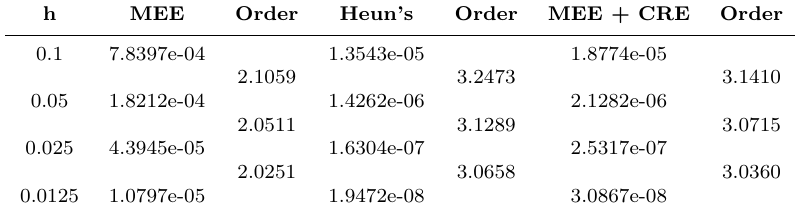
Table 2. Global errors at T = 1 in absolute value in Example (4.3) obtained by the modified Euler (MEE), Heun’s and MEE + CRE methods and reducing h by a factor of 2. h MEE Order Heun’s Order MEE + CRE Order 0.1